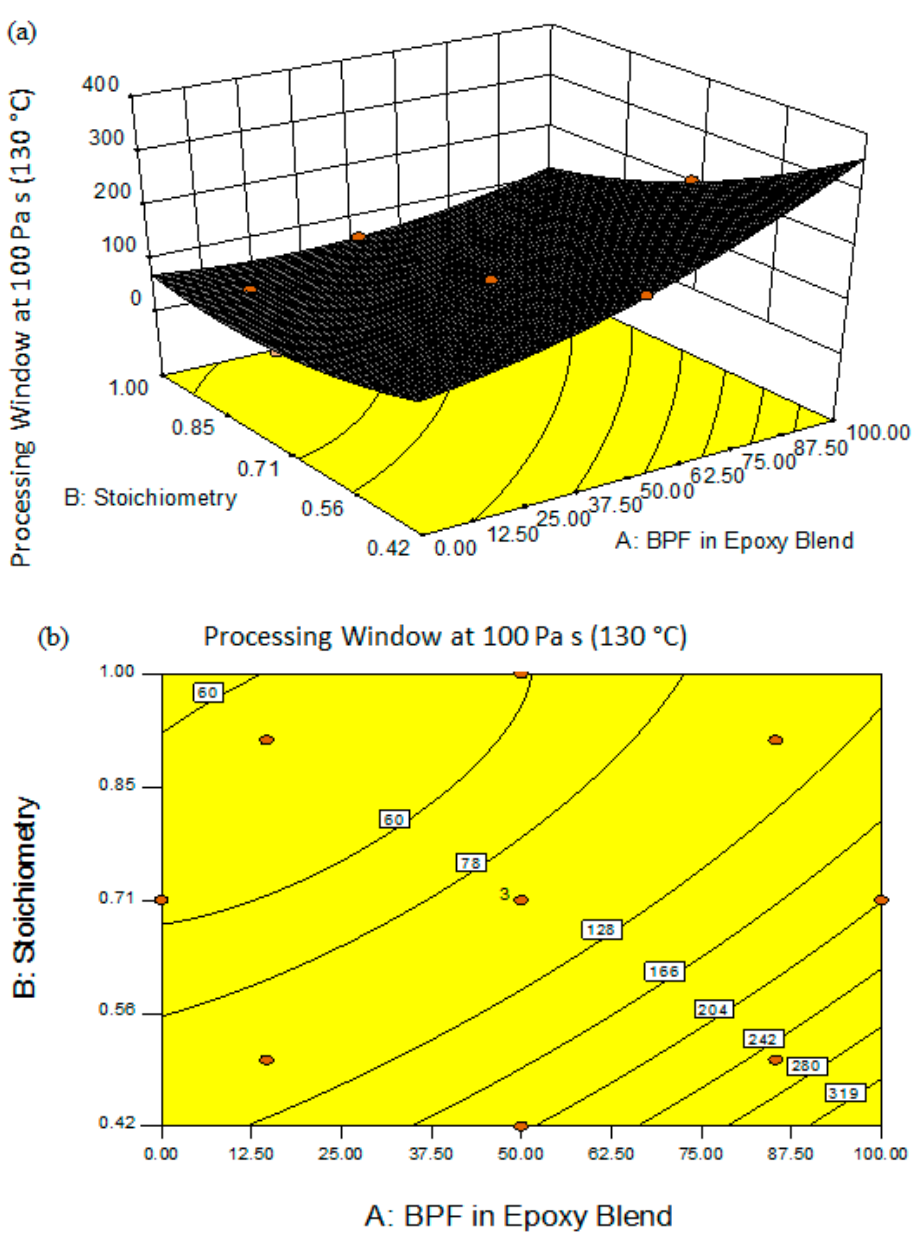
Figure 13. Response surface for PW of BPF/TGPAP/DDS epoxy blend resins ( a ) 3D plot, and ( b ) contour plot.